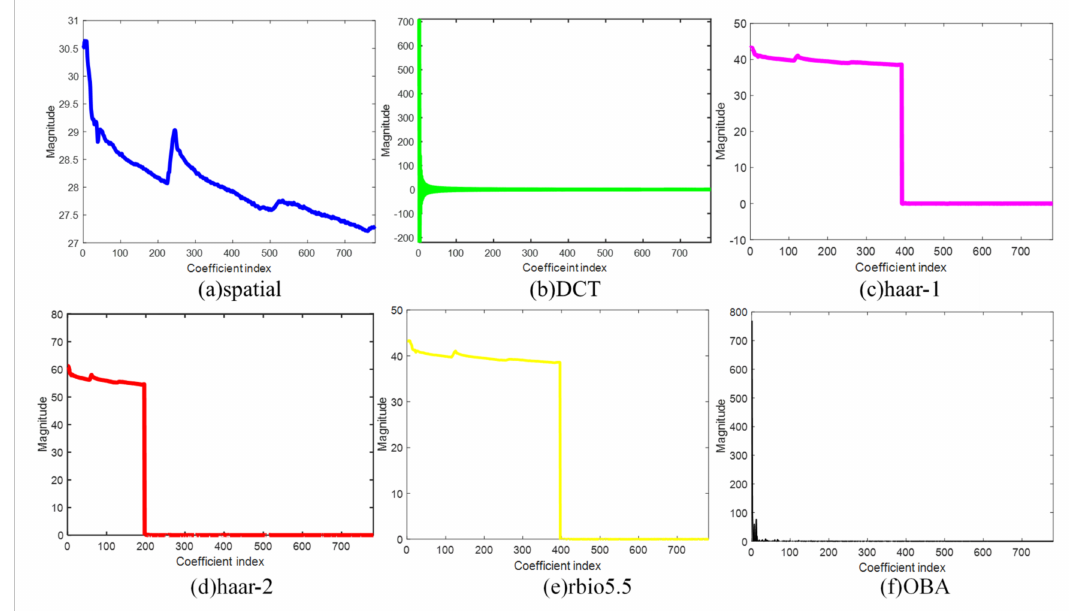
Figure 7. Sparsity performance of temperature of DEI-Campaign A in six various sparse bases.